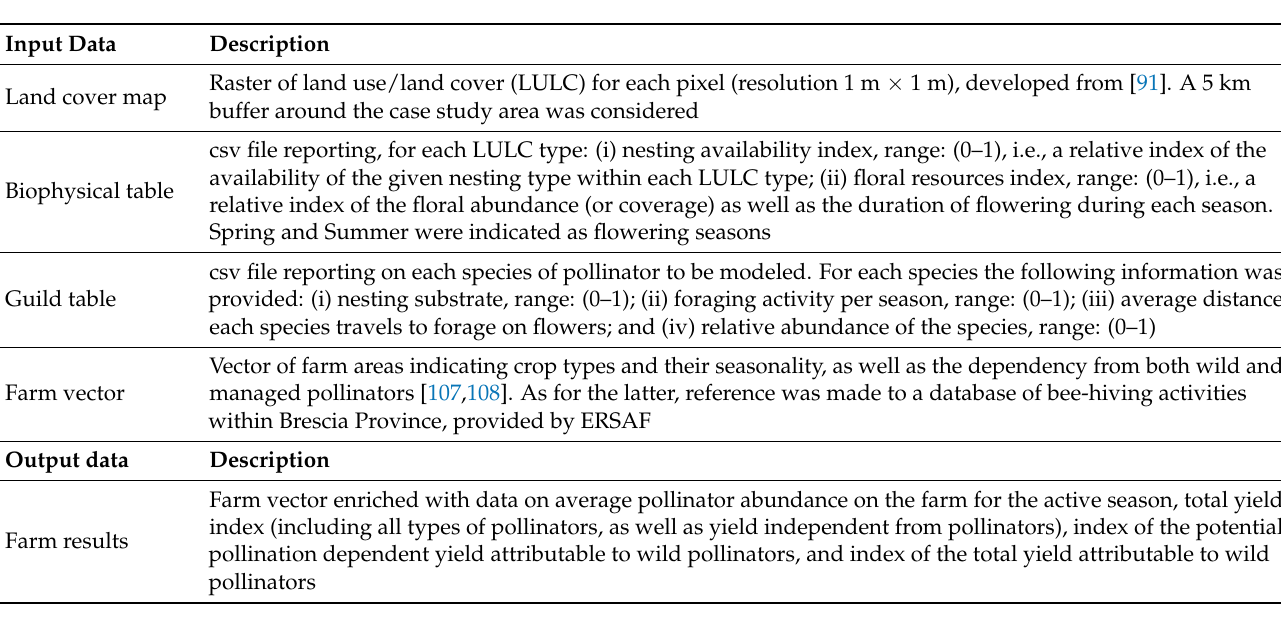
Table 7. Input and output data for the assessment of